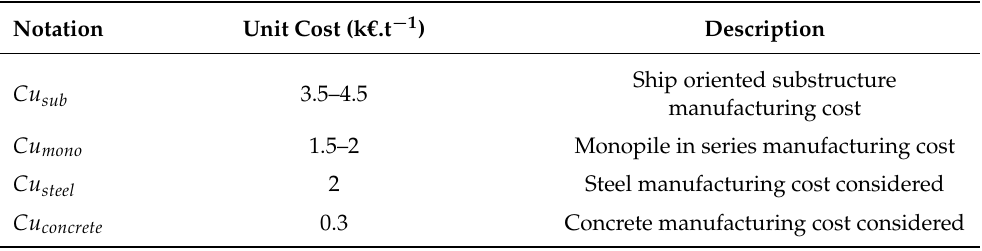
Table 2. Manufacturing costs including material costs implemented for the cost